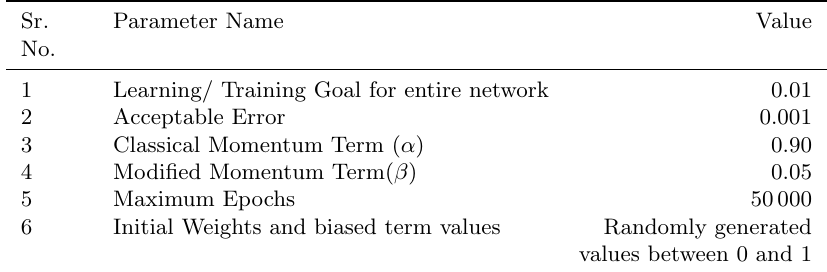
Table 1: Parameters and their values used in the learning processes.